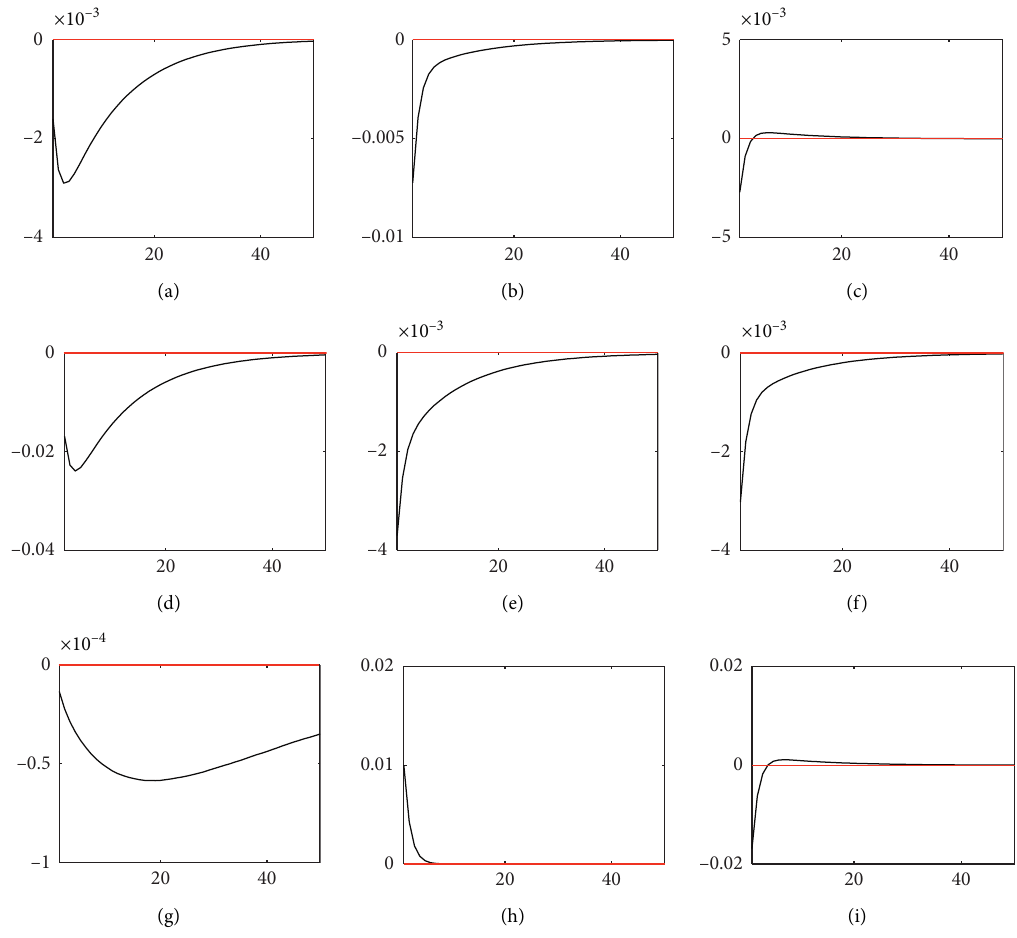
Figure 3: Impulse response to an environmental tax rate shock. (a) C . (b) W . (c) N . (d) K . (e) Y . (f) Z . (g) G . (h) T . (i) I